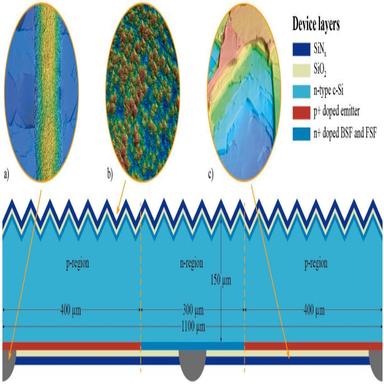
Characteristic period of the Zebra IBC SC; schematic cross-section taken perpendicular to the rear contact fingers. The insets show the regions of a) rear metallization, b) textured front surface, and c) polished rear surface.